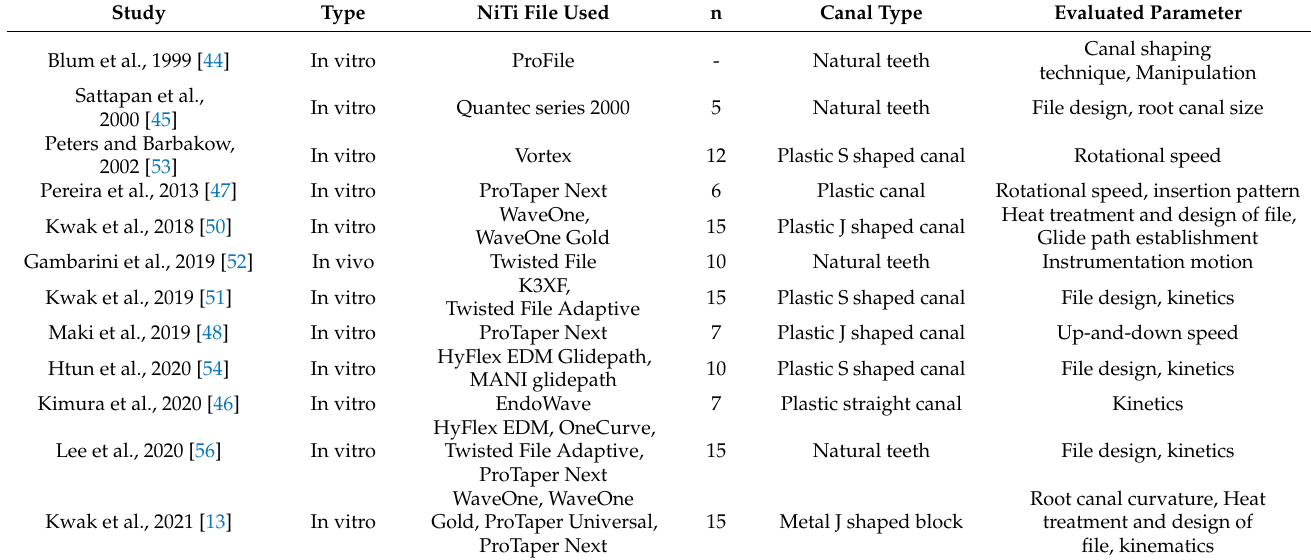
Table 1. A summary of the methodology of the studies that evaluated the torque generated in this